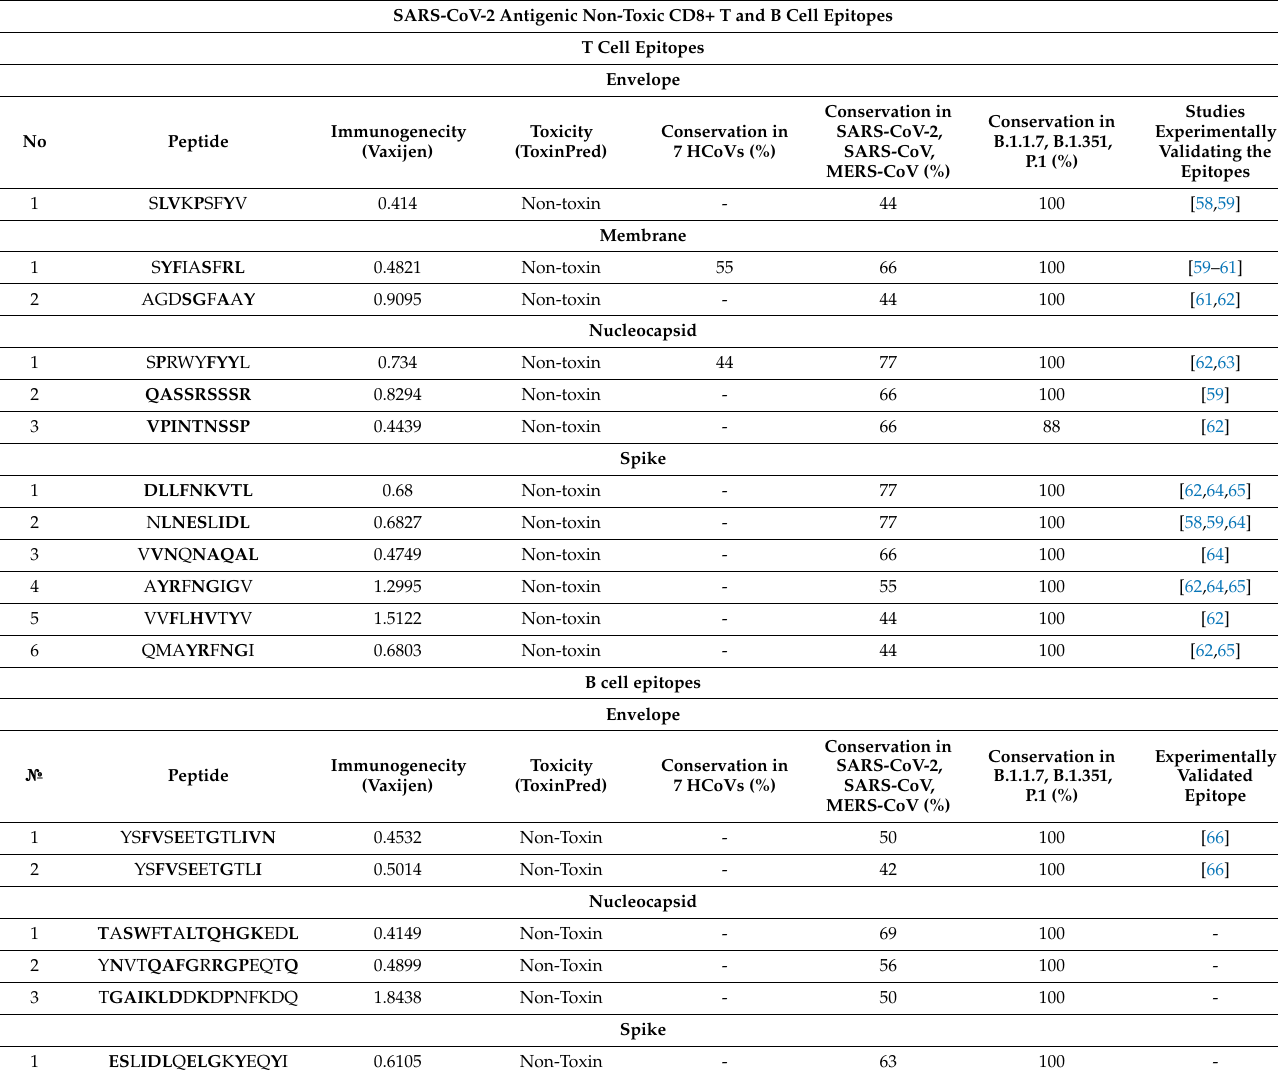
Table 5. List of immunogenic and non-toxic T and B cell epitopes from E, N, M, and S proteins. The table shows sequences of the shortlisted epitopes, their immunogenicity and toxicity score, and conservation (including level of conservation) between seven HCoVs and the three closely related SARS-CoV-2, SARS-CoV, and MERS-CoV as well as in three variants of SARS-CoV-2. The last column shows whether these epitopes have previously been experimentally validated or not. SARS-CoV-2 Antigenic Non-Toxic CD8+ T and B Cell Epitopes T Cell